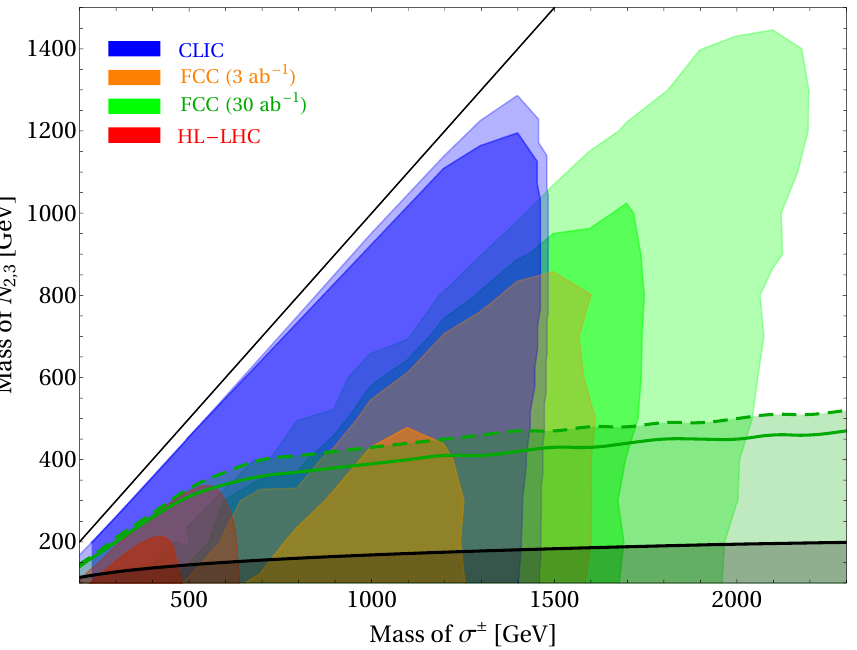
Figure 11 . Summarized sensitivity curves as discussed in sections 4.2, 5.2 and 5.1. The light shaded regions correspond to S = 2 and the darker regions represent S = 5. Again, the thin black line indicates m N = m whereas thick black line shows BBN constraints; green solid (dashed) 2 ; 3 (cid:6) curves represent conservative ( aggressive ) N e(cid:11) constraints. We assumed a maximal coupling to e; (cid:22) in this